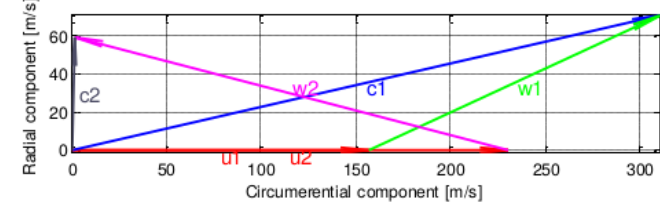
Figure 2: Velocity triangles of the centrifugal stage.